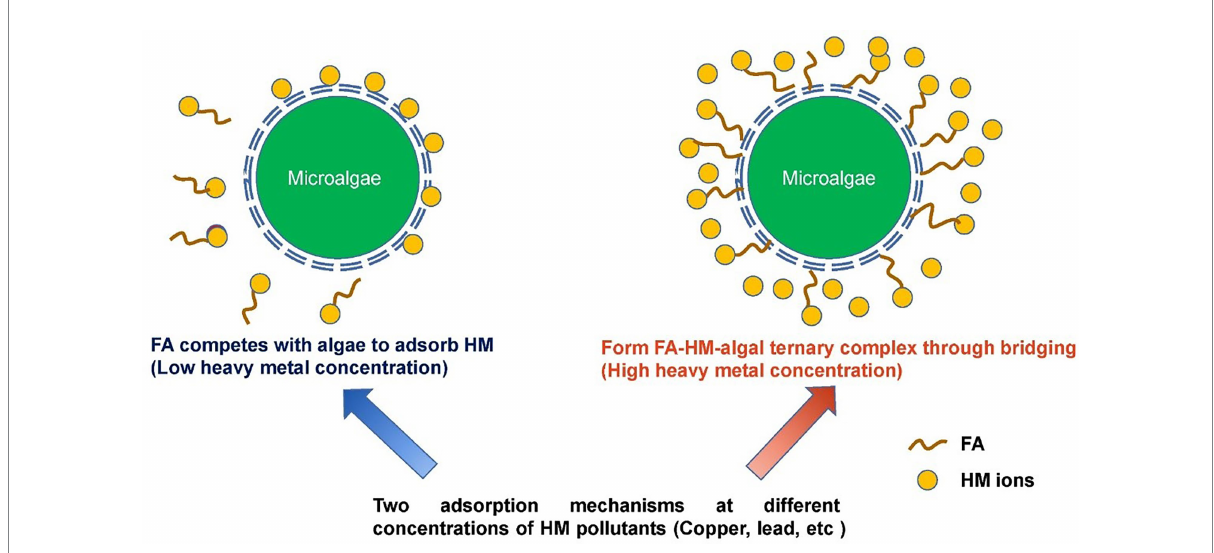
FIGURE 3 Mechanisms of metal adsorption by microalgae in the presence of FA (Shi et al.,